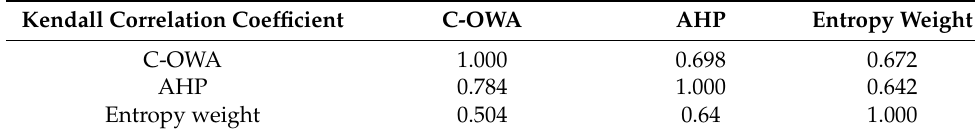
Table 8. Kendall correlation coefficient test